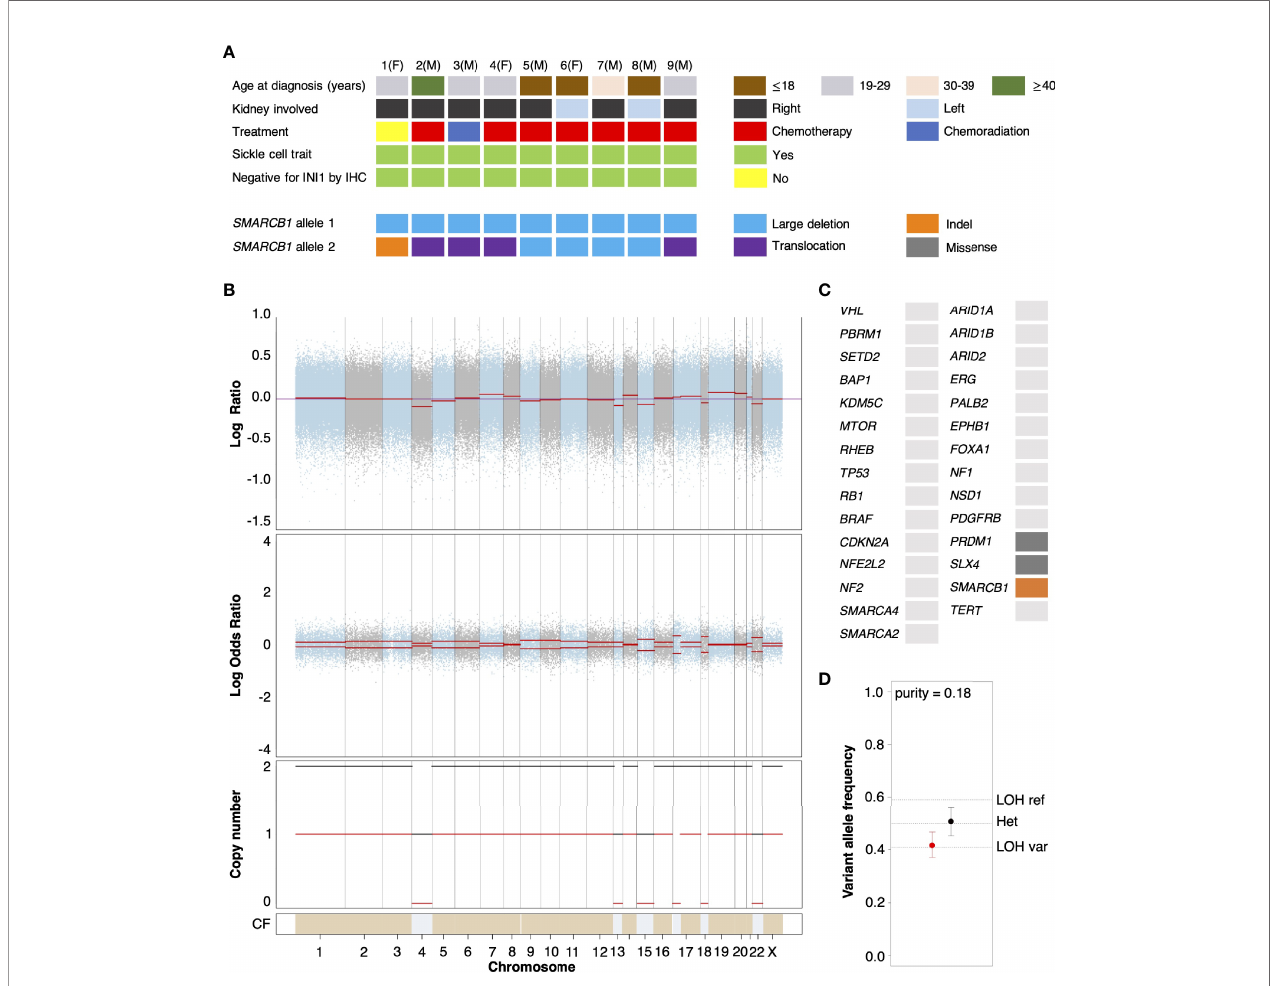
FIGURE 1 | Genomic characterization of primary RMC tumors. (A) Oncoplot showing the clinical characteristics and genetic mechanisms of SMARCB1 inactivation in nine RMC patients molecularly pro fi led at Memorial Sloan Kettering Cancer Center. Each column represents a different patient as ordered starting with Patient 1, with parenthesis indicating sex chromosome status (male (M), sex chromosome pair XY; female (F), sex chromosome pair XX). (B) Integrated visualization of FACETS analysis for WES data from Patient 1. Top two panels display total copy number Log Ratio and allele-speci fi c Log Odds Ratio with chromosomes alternating in blue and grey. Third panel plots the corresponding integer total (black) and minor allele (red) number calls. Estimated cellular fraction (CF) is plotted at bottom in blue with normal diploid state in tan. (C) Somatic genomic alterations found in Patient 1 (not including germ line TP53 allele loss) as reported by MSK-IMPACT analysis, plotted using the same color scheme as in (A) . (D) Variable allele frequencies (VAFs) of the (likely) pathogenic germ line TP53 variant inherited by Patient 1 for tumor (red) and normal (black) samples. Vertical bars represent 95% con fi dence intervals and VAFs corresponding to different allelic con fi gurations of the reference and variant copies of TP53 are shown as dotted lines. The VAFs of tumor and normal tissue are judged to be signi fi cantly different based on a p-value of